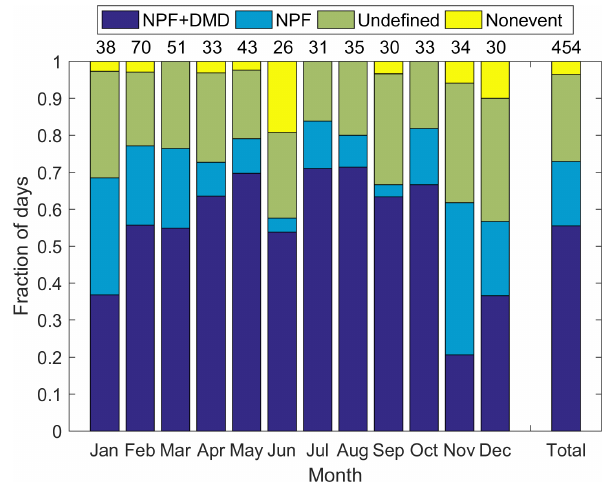
Figure 2. Results of the NPF event classification as fractions of classified days, separately for each month and all of the classified days. The numbers above the bars show the number of classified days. Some of the months contain days from more than a year, while in some months (June, July, September and December) data were available only for a single